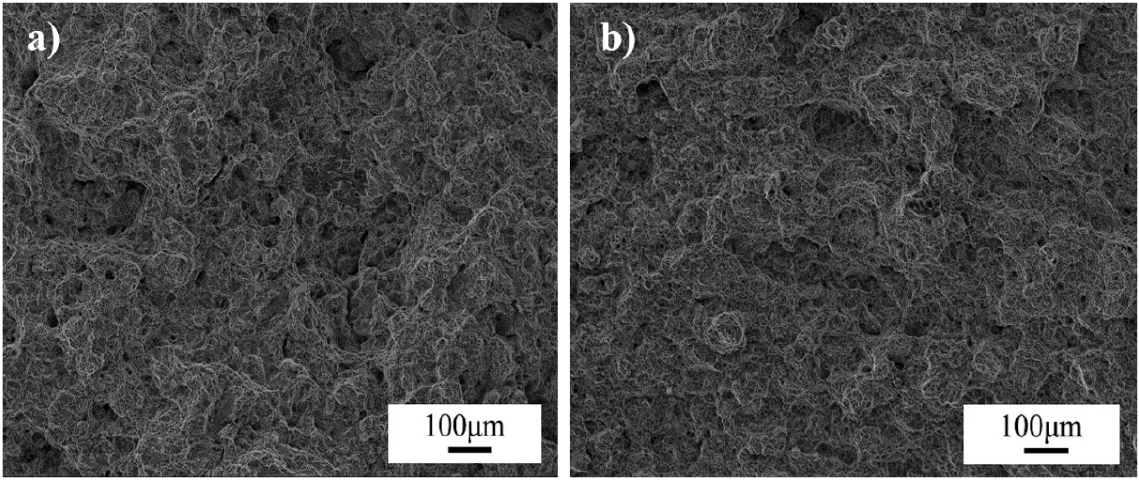
Figure 9. Fracture surface following ratcheting tests for J12: ( a ) 100 ± 800 MPa; ( b ) 100 ± 750 MPa. Table 3. Relationship between stress amplitude and cycle order obtained from a ratcheting test for the two different wheel steels.